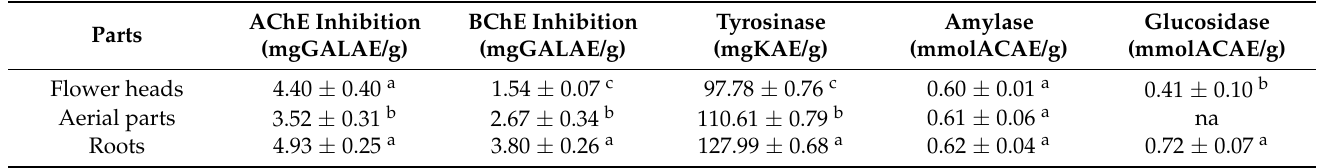
Table 3. Enzyme inhibitory properties of Cirsium appendiculatum extracts